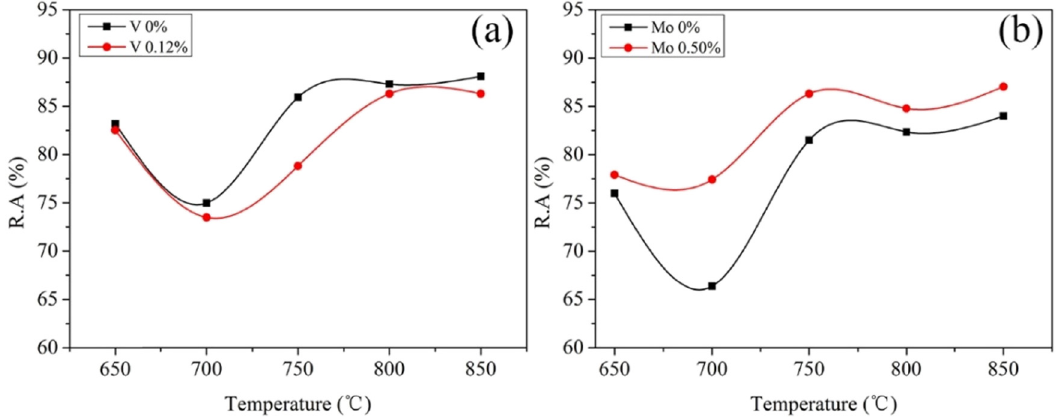
Figure 12: Hot ductility curves with a strain rate of 0.005 s − 1 : ( a ) steel 5# and 6#; ( b ) steel 7# and